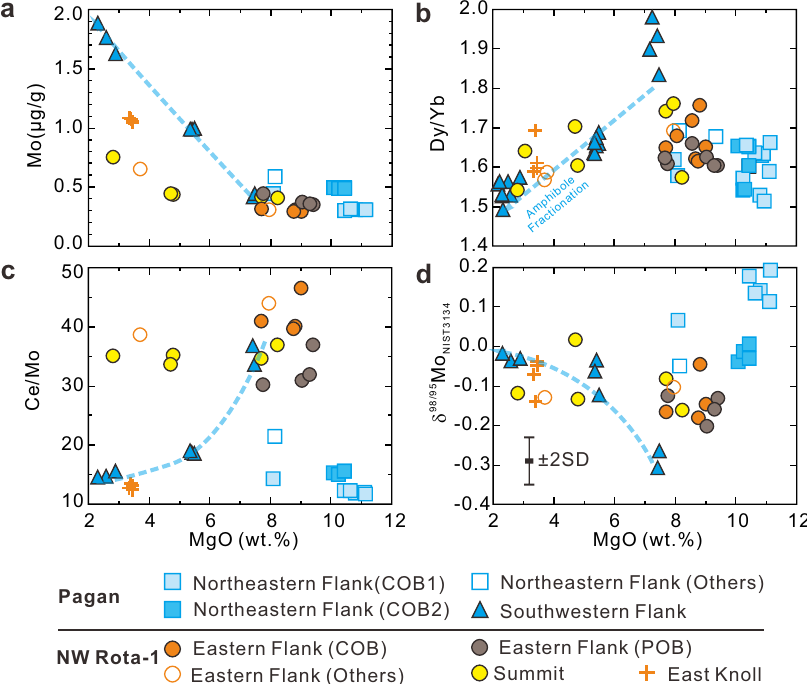
Fig. 2 Chemical variations due to magmatic evolution to form Pagan and NW Rota-1 volcanic rocks. Plots of a Mo, b Dy/Yb, c Ce/Mo, and d δ 98/95 Mo vs. MgO diagrams for the Pagan and NW Rota-1 samples. COB clinopyroxene-olivine basalt, POB plagioclase-olivine basalt, SD standard deviation, which is based on duplicate analyses of standard solution NIST SRM 3134, reference materials AGV-2 and W-2a, IAPSO seawater standard, and unknown